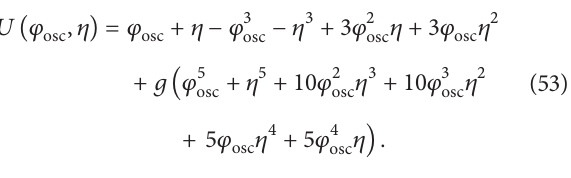
= 0.28 , 𝑘 = 0.30 , 𝑘 = 0.27 , and 𝑘 = 0.37 and the thick line to the case with 𝑘 00 11 01 10